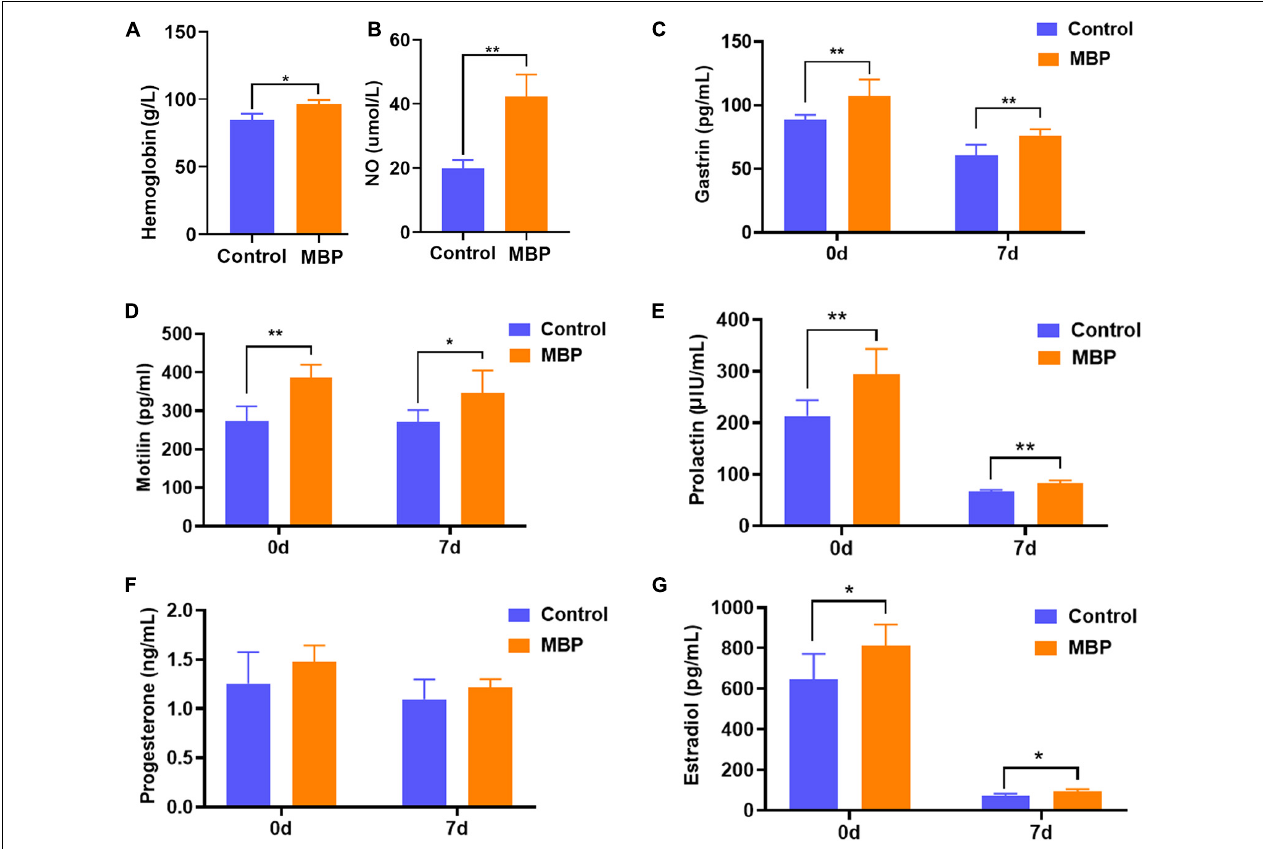
FIGURE 2 | Effects of MBP on physiological and biochemical parameters in the blood of lactating sows. (A,B) Levels of hemoglobin and serum NO in sows on the day of farrowing. (C,D) Levels of serum gastrin and plasma motilin of sows on days 0 and 7 postpartum. (E–G) Serum levels of PRL, progesterone, and estradiol of sows on days 0 and 7 postpartum. Data represent mean ± SD. * p < 0.05, ** p < 0.01 versus control.